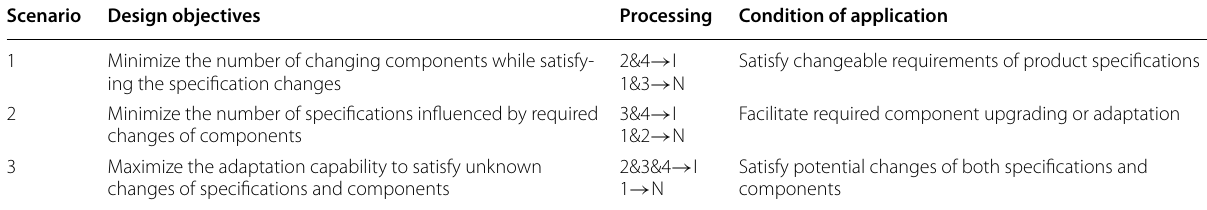
Table 2 Relation transfer based on different design objectives Scenario Design